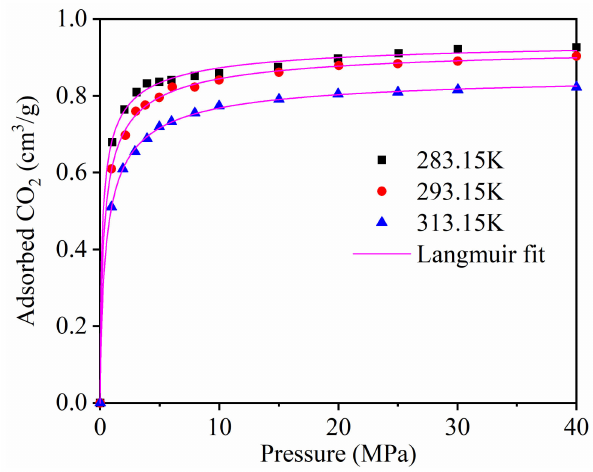
Figure 2. The adsorption isotherms of CO 2 at di ff erent temperatures.